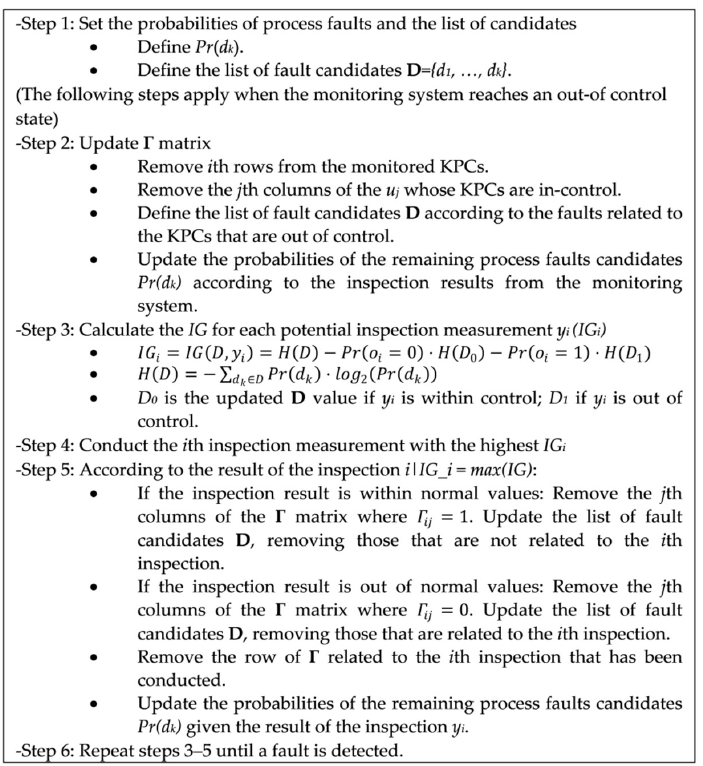
Figure 6. Algorithm for the sequential inspection procedure.